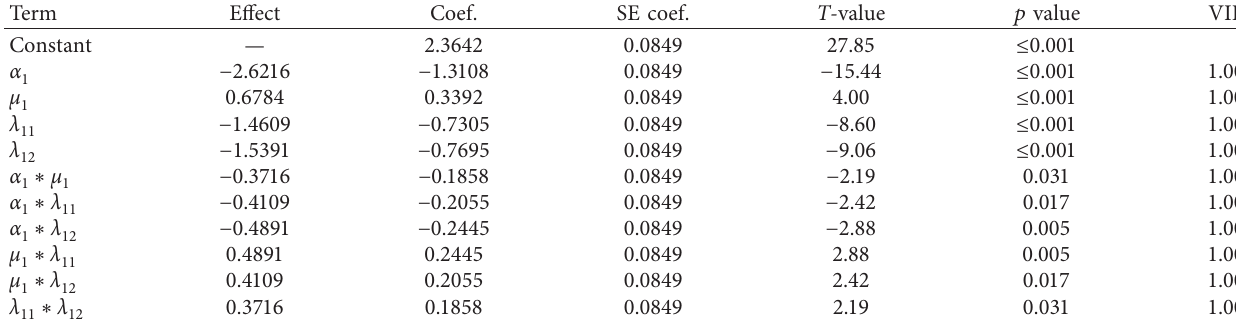
Table 5: Coded regression model coefficients.